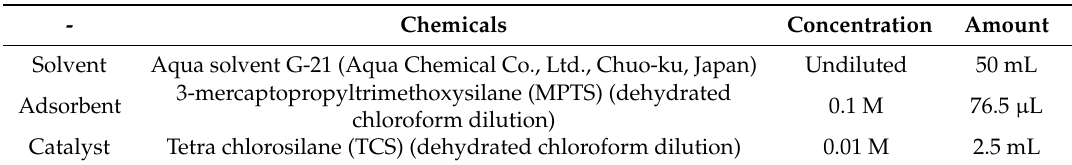
Table 3. Conditions for preparing the adsorption solution.